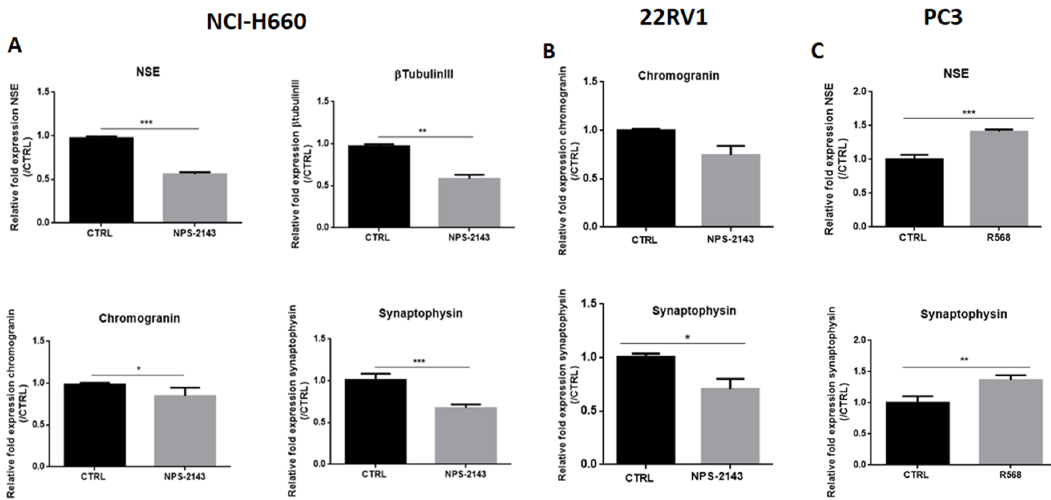
Figure 4. ( A , B ): E ff ects of CaSR inhibitor on the expression of NE markers in NCI-H660 and 22RV1. Cells were treated for 72 h (NCI-H660) or 24 h (22RV1) with a CaSR inhibitor, NPS-2143 at 1 µ M (NCI-H660) or 300 nM (22RV1). ( C ): E ff ects of CaSR activator on the expression of NE markers in PC3. Cells were treated for 24 h with a CaSR activator, R-568 (10 µ M) in presence of calcium (1.2 mM). qPCR results are normalized to control condition and are expressed as mean ± S.E.M. The statistical di ff erences are indicated: * p < 0.05; ** p < 0.01; *** p < 0.001 (Mann–Whitney). n =